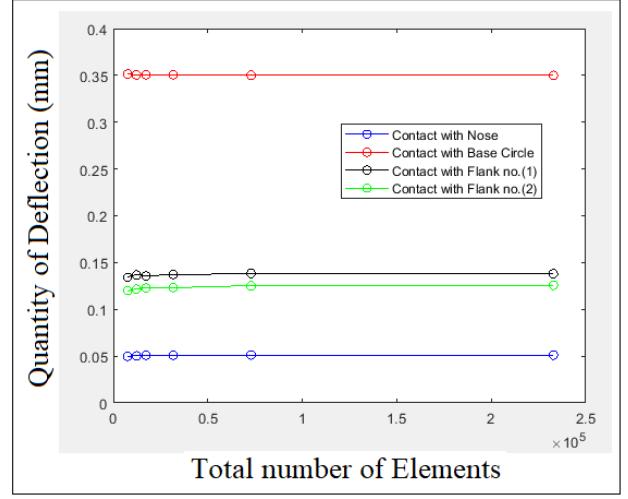
Figure 8. Convergence test of the bending deflection quantity at different contact locations for profile no.(1).